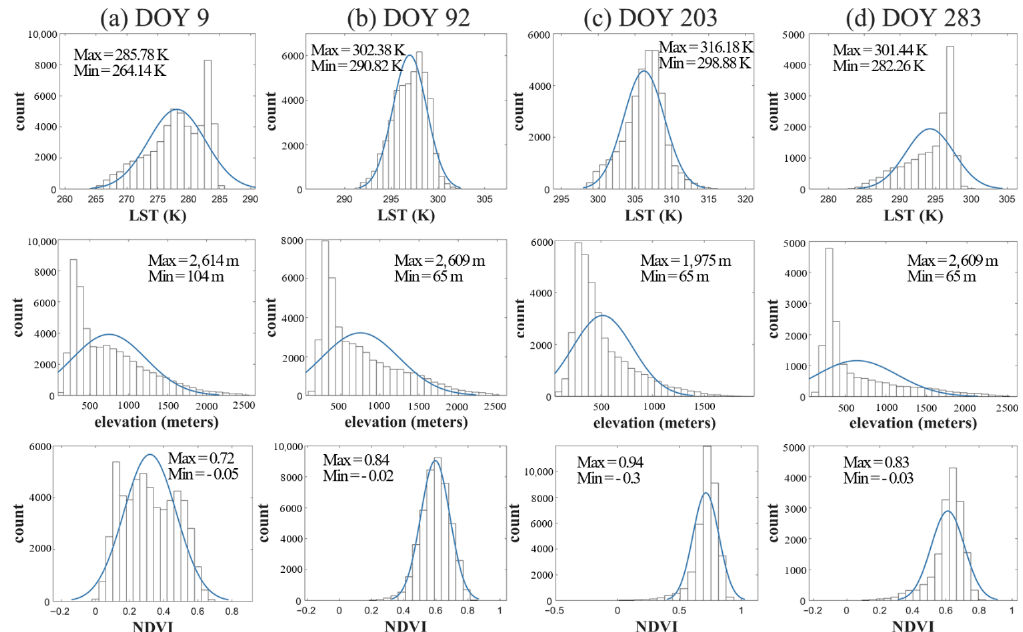
Figure 5. Histogram profiles of LST, elevation and NDVI on four days in 2018 (DOY 9, DOY 92, DOY 203 and DOY